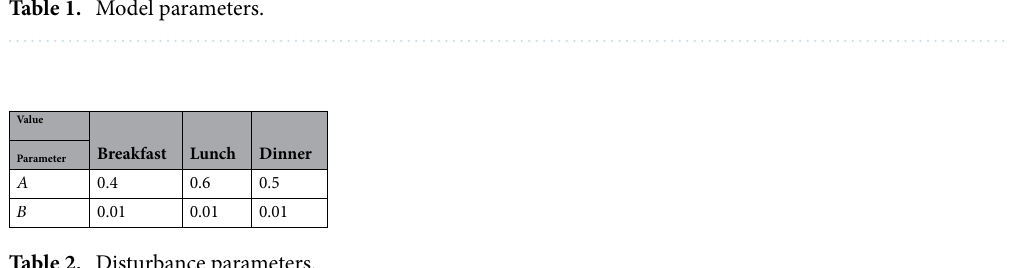
Table 1. Model parameters.